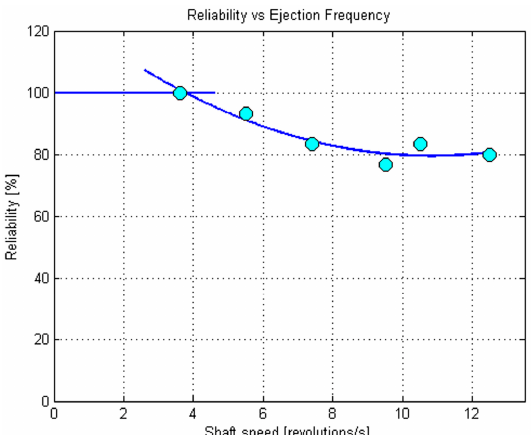
Figure 6. Graphical representation of the reliability trend for the singularization tests with 0.6 mm micro-spheres. Micromachines 2017 , 8 , 273 11 of 13